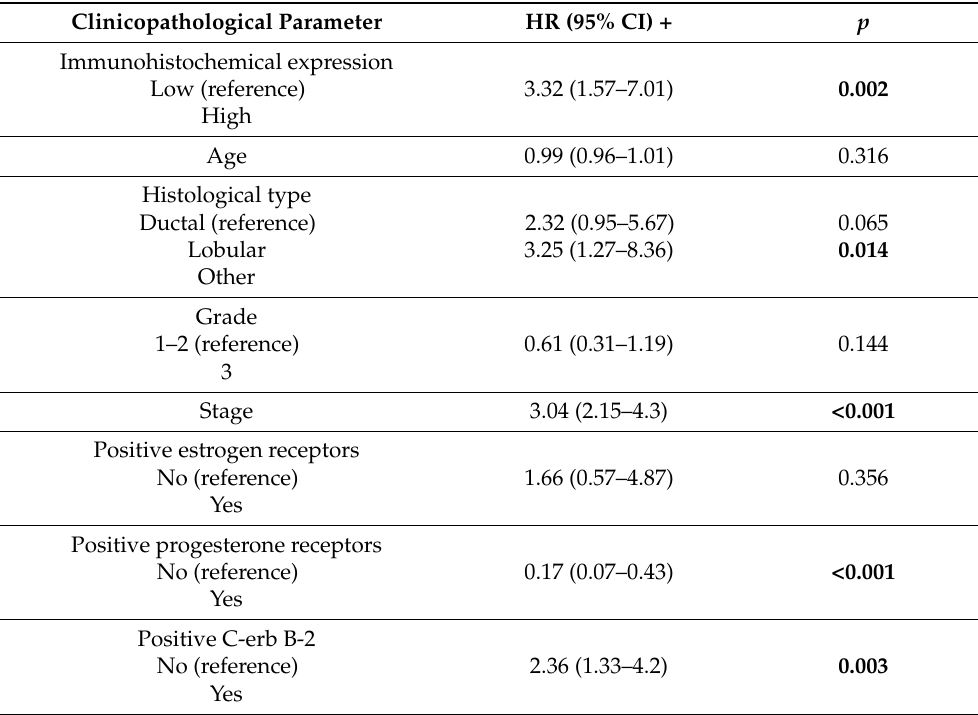
Table 3. Multiple Cox regression analysis results for disease-free survival.